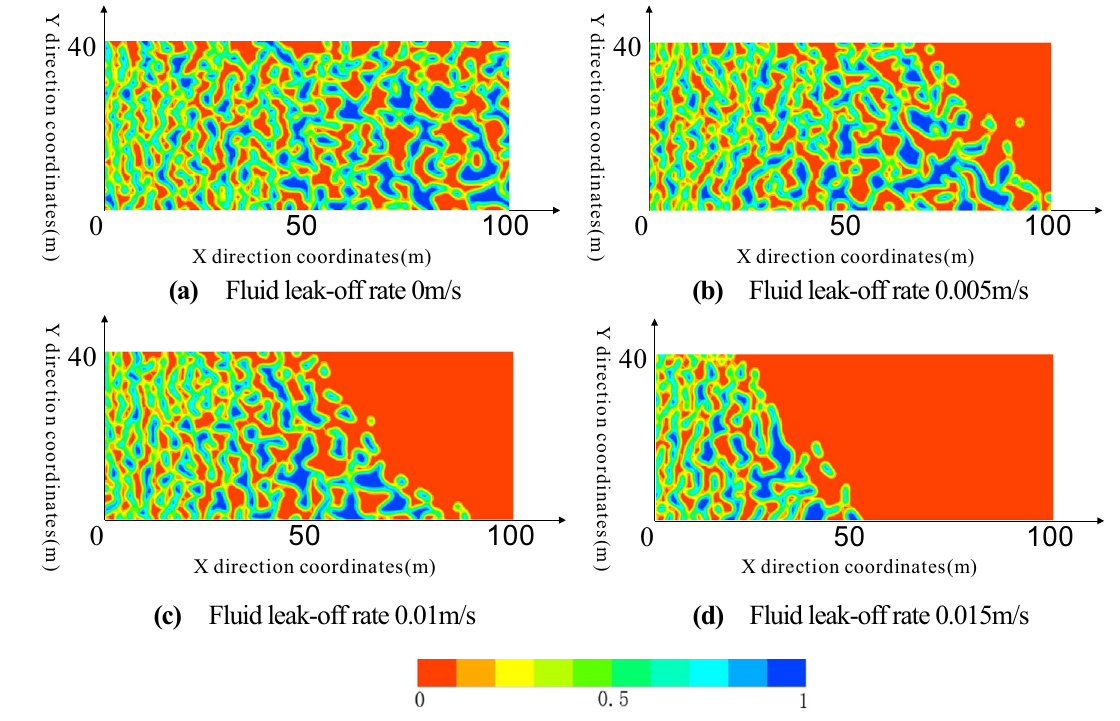
Fig. 5 Volume fractions of the self-propping fracturing liquid at different fluid leak-off rates